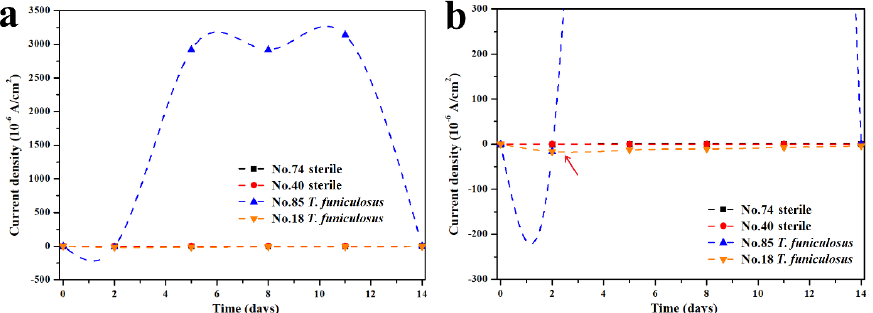
Figure 5. Variation in the current density of the #74 and #40 electrodes after the immersion in a sterile liquid medium and of the #85 and #18 electrodes after the immersion in the T. funiculosus - contained medium for 14 days ( a ) and the correspondingly partially enlarged line chart ( b